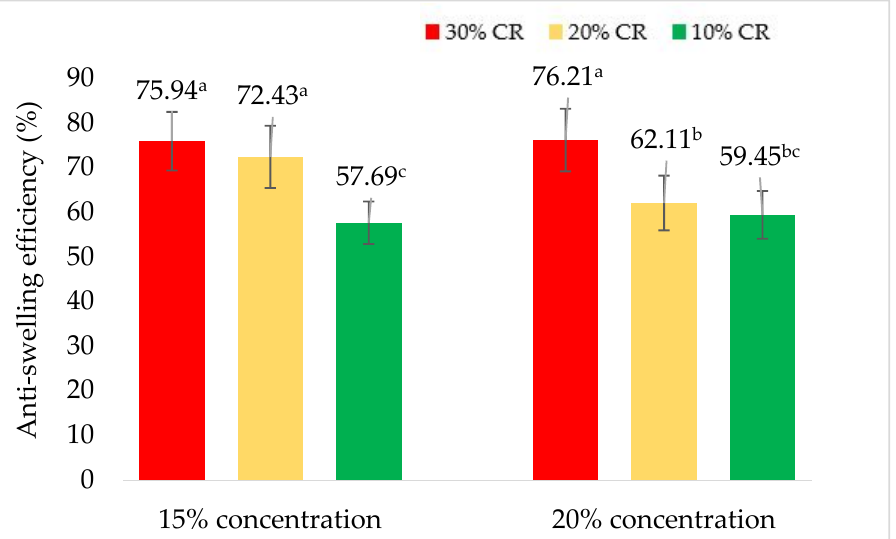
Figure 4. Anti-swelling efficiency of compreg oil palm inner wood. Note: Means followed by the same letter a, b, c is not significantly different at p ≤ 0.05